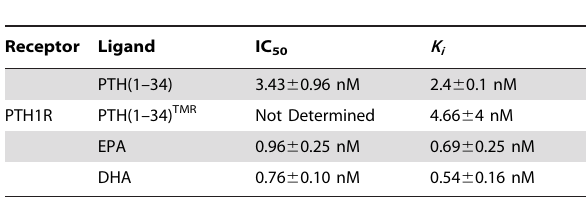
Table 1. Summary of binding